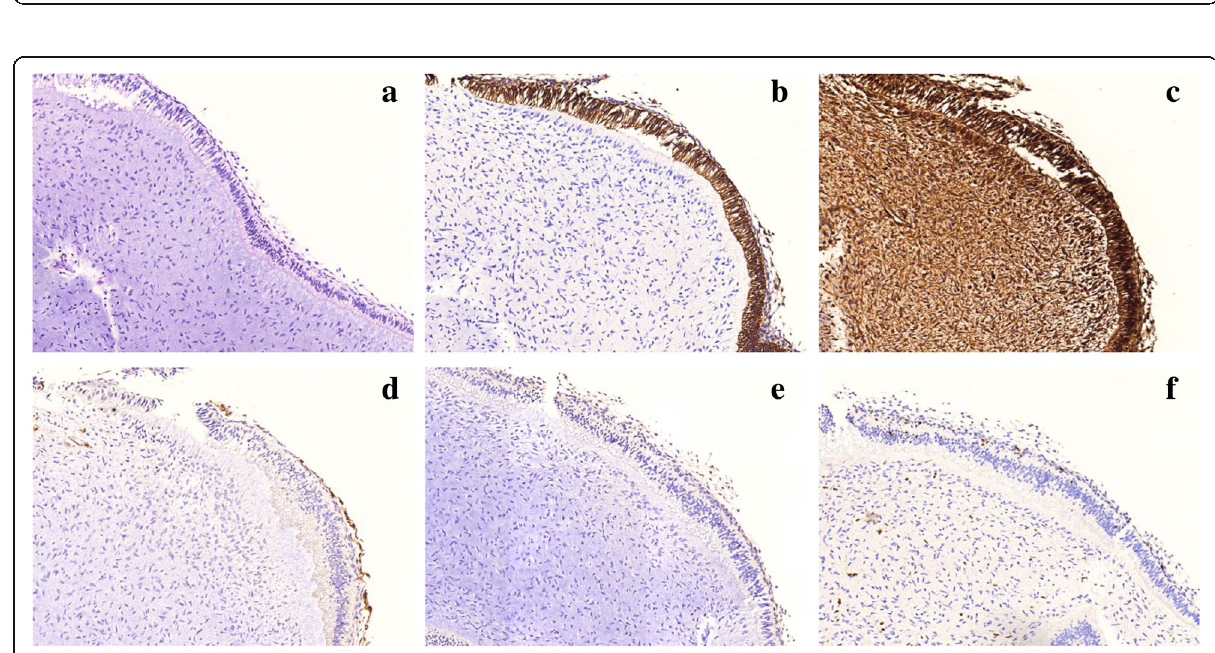
Fig. 2 Microscopic findings of the POT. a It consisted of a proliferation of cellular myxoid connective tissue, which is less vascular, less cellular, and more collagenous. The periphery of the tumor is surfaced by a monolayer of columnar epithelium. The cord-like or nests of enfolded epithelium are present (hematoxylin and eosin stain; magnification, × 40). b The external aspect of the tumor is surfaced by columnar epithelial cells, which show “ reverse nuclear polarization ” (nuclei displaced away from the connective tissue and cytoplasm showed vacuolated at the bottom part) (magnification, × 200). c The cord-like or nests of the enfolded epithelium possessed stellate reticulum between the columnar cells (magnification, × 200). d Dentine existed adjacent to the tumor (magnification, × 40)